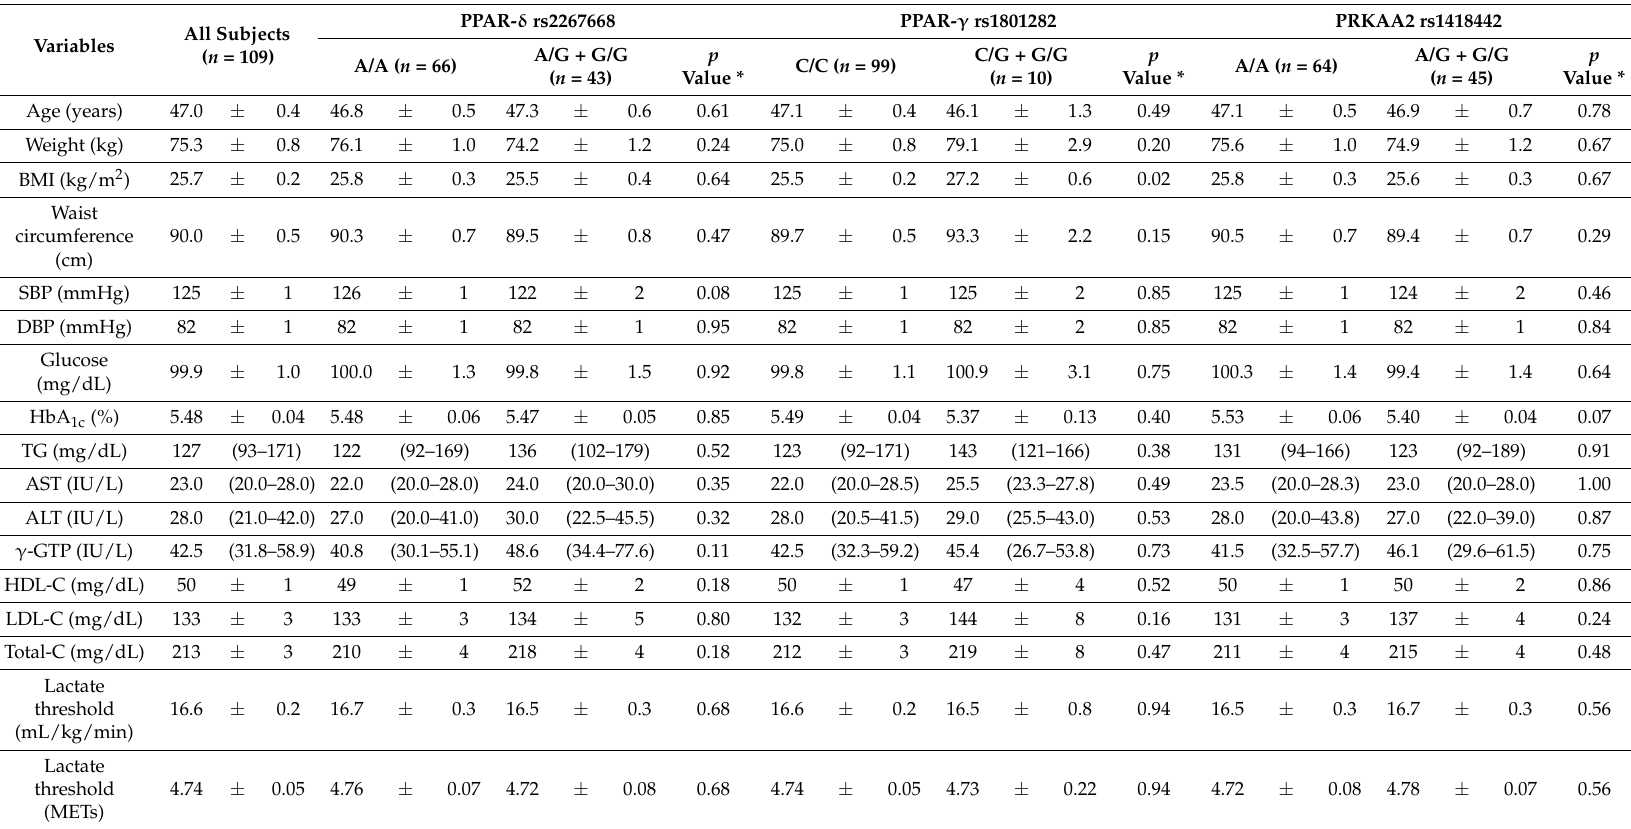
Table 1. Baseline characteristics of the subjects according to genotypes of PPAR- δ , PPAR- γ , and PRKAA2